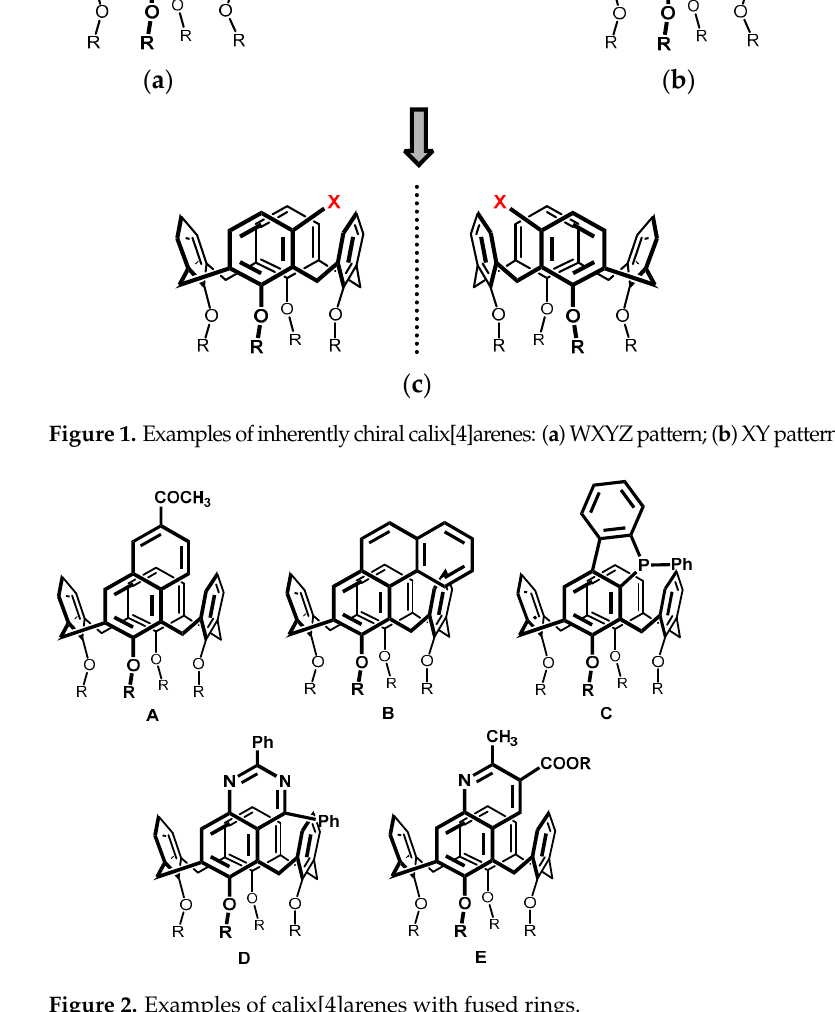
Figure 1. Examples of inherently chiral calix[4]arenes: ( a ) WXYZ pattern; ( b ) XY pattern; ( c ) meta substitution.